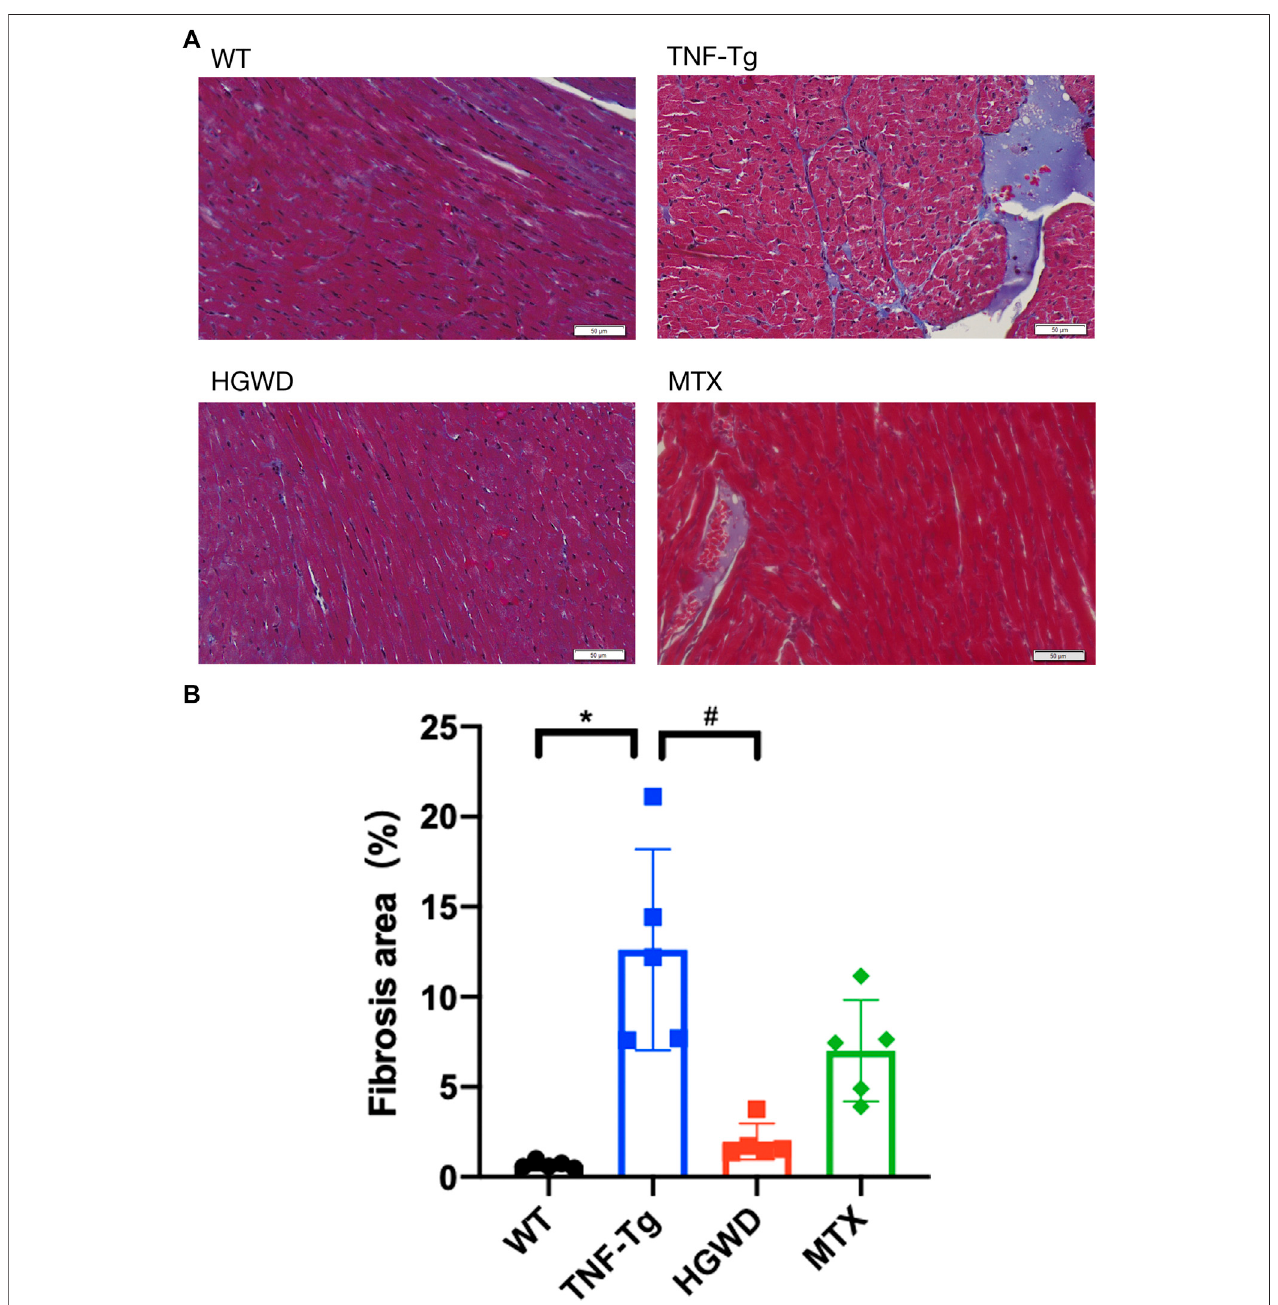
FIGURE 4 | HGWD reduces myocardial fi brosis in TNF-Tg mice. (A) Representative Masson-stained sections of mouse heart showed obvious fi brosis, and the area of fi brosis decreased after HGWT treatment. Bar = 20 μ m. (B) Quanti fi cation of the area of myocardial fi brosis. Values are the mean plus or minus SD of 5 hearts in each group. * p < 0.05, compared with WT group; # p < 0.05, compared with TNF-Tg